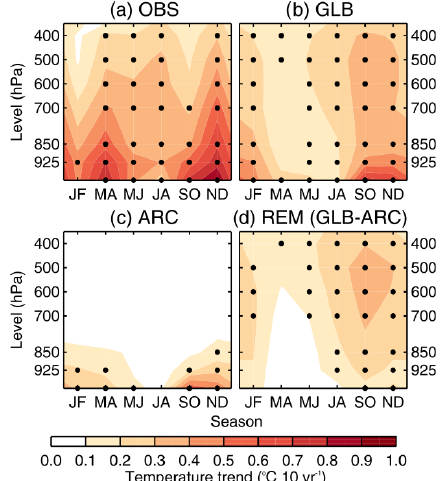
Figure 3. Local and remote drivers of Arctic warming. (a) Verti- cal and seasonal structure of the reanalysis ensemble-mean (OBS) Arctic-mean temperature trends (1979–2008). (b–d) As in panel (a) but for the model ensemble-mean simulations forced by observed changes in global SST and SIC (GLB), observed changes only in Arctic SIC and associated SST (ARC), and their difference (REM), respectively. Black dots show trends that are statistically significant at the 95% level ( p < 0 . 05). These experiments enable the relative contributions of local (ARC) and remote (REM) processes to Arc- tic trends to be assessed, giving insight into the driving mechanisms. Source: Screen et al. (2012).